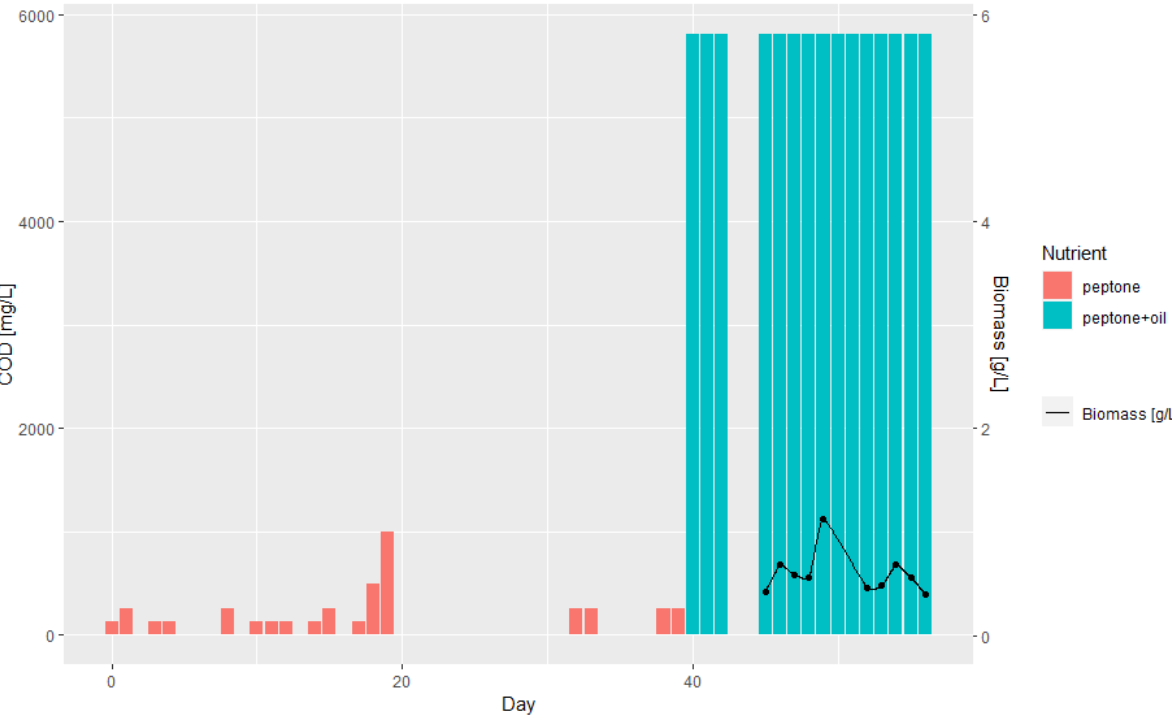
Figure 9. The time relationship between chemical oxygen demand, nutrient medium, and biomass in a continuous-flow bioreactor.